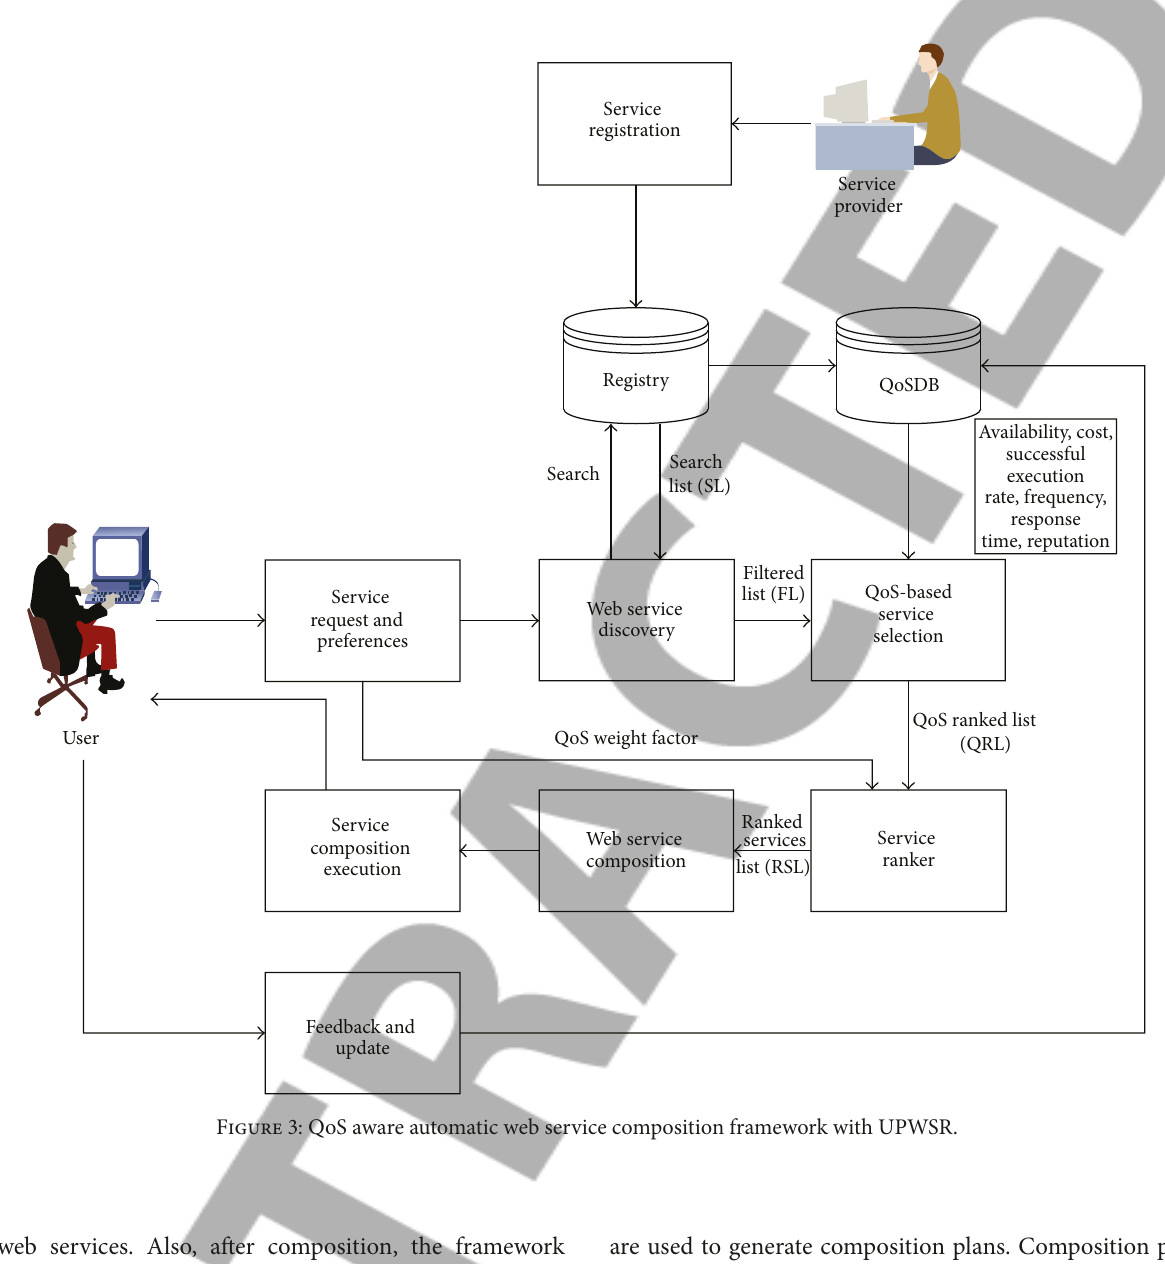
Figure 3: QoS aware automatic web service composition framework with